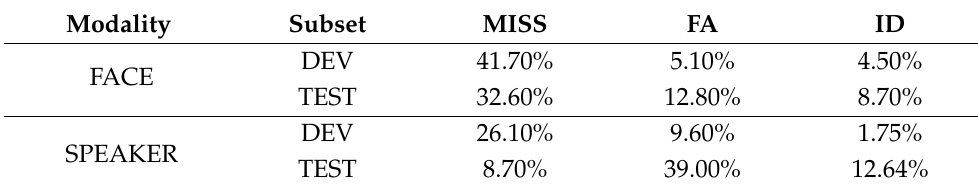
Table 5. Decomposition of DER% results in miss (MISS), false alarm (FA), and identity (ID) errors for the development and test sets in both